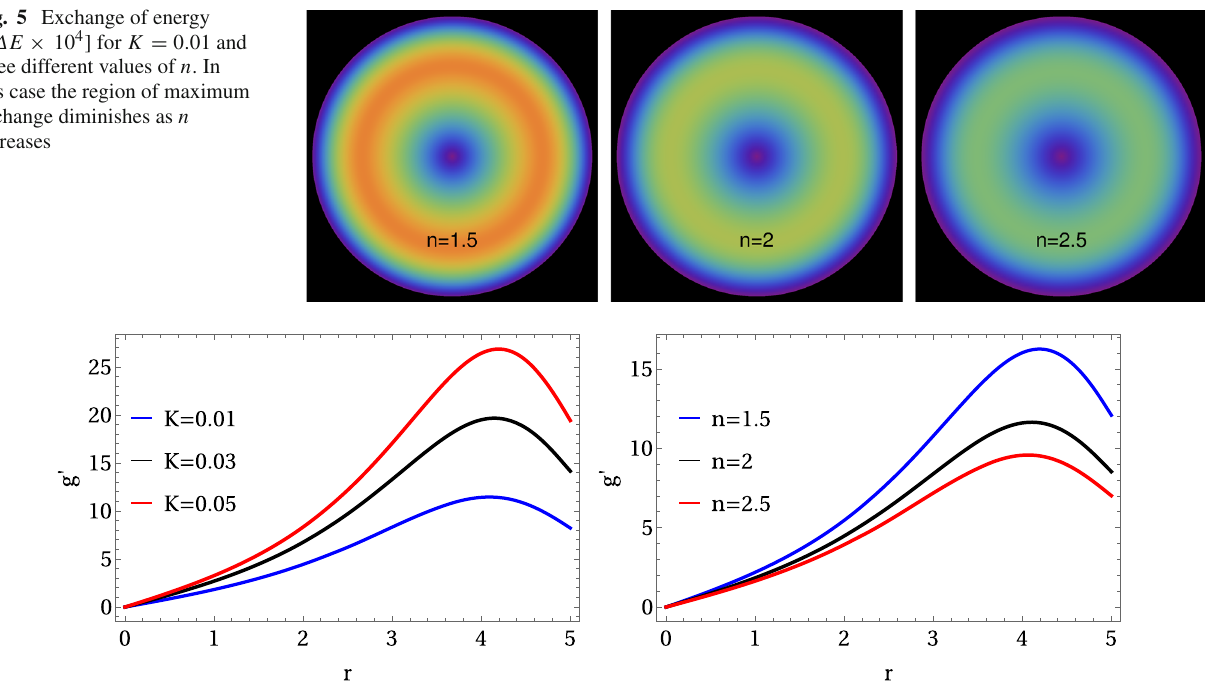
Fig. 5 Exchange of energy [ 2 Δ E × 10 4 ] for K = 0 . 01 and three different values of n . In this case the region of maximum exchange diminishes as n increases